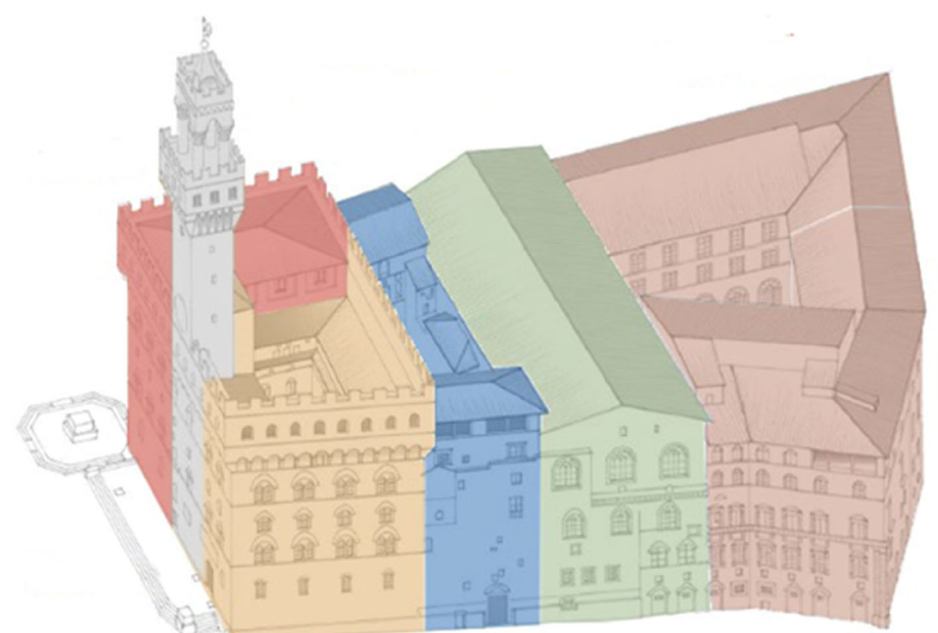
Figure 6. Overview of Palazzo Vecchio with the division of the different structural units. From left, in red, grey and orange the three units composing Palazzo dei Priori (Sala D’Armi unit, Arnolfo’s Tower and Michelozzo’s Courtyard respectively); in blue, the Dogana unit, in green, the Salone unit, in dark orange, the Third Courtyard unit.